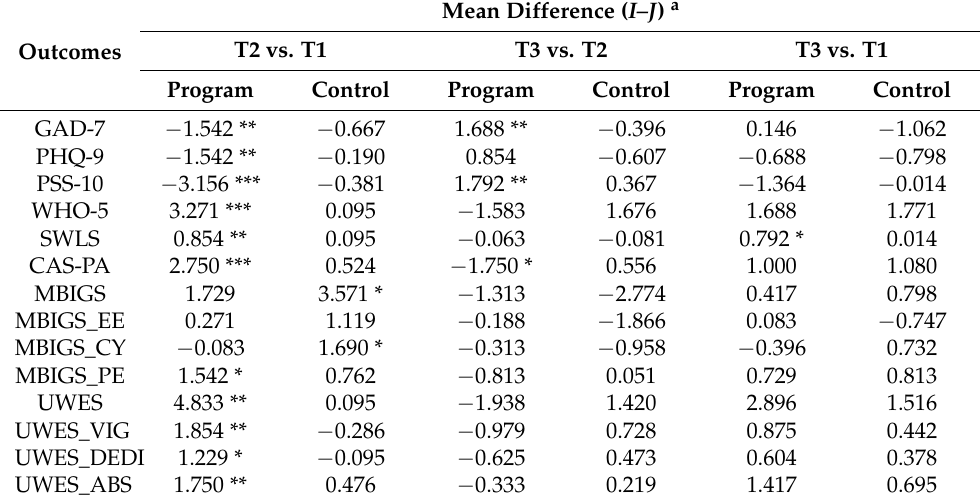
Table 3. Mean difference of all outcomes within groups (program and control) across timepoints (T1, T2, and